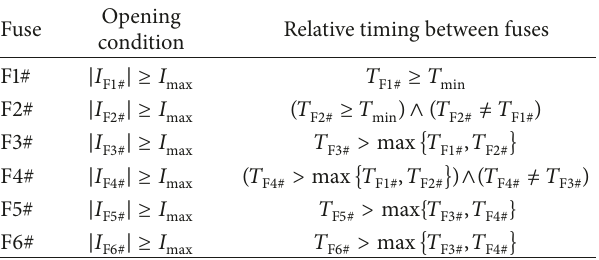
Table 2: Fuse ratings (or overcurrent shut-off ratings).